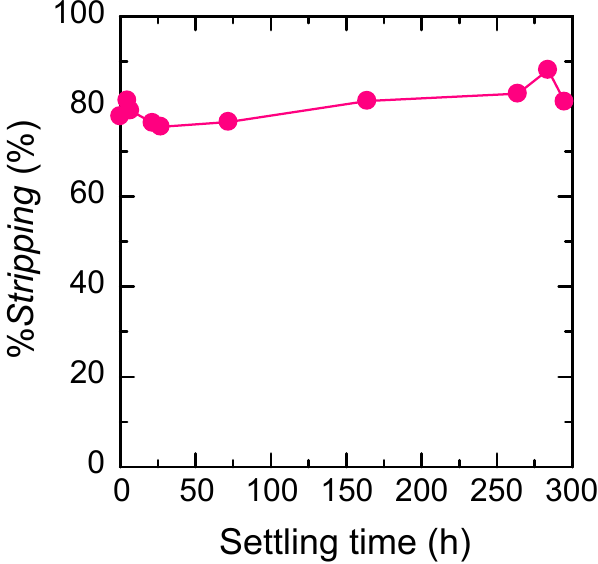
Figure 8. Effect of settling time of the Pt(IV) loaded organic phase on the stripping percentage of Pt(IV) by MonoAA. [MonoAA] org,i = 1.0 M in n -dodecane/2-ethylhexanol (80 vol%/20